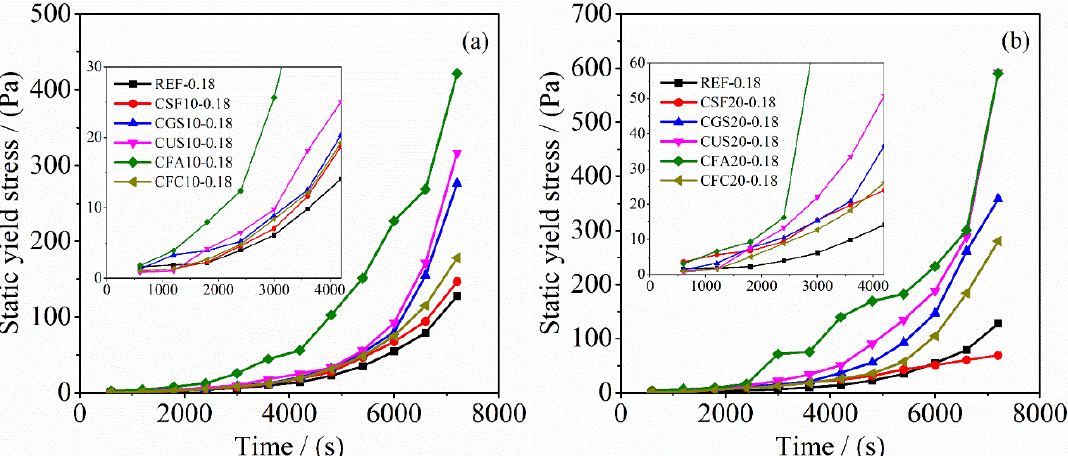
Figure 13. Effect of different mineral admixtures on the evolution of static yield stress of UHPC-based pastes: ( a ) containing 10% of mineral admixture, ( b ) containing 20% of mineral admixture. The water film thickness of UHPC-based pastes is shown in Figure 14.